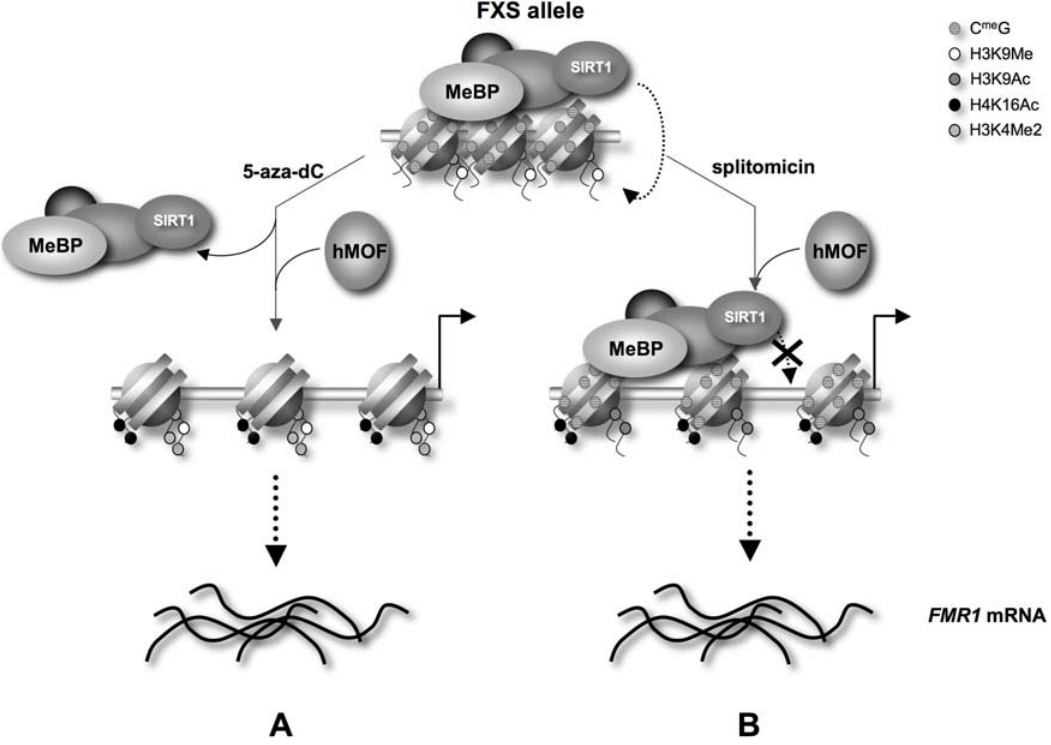
Figure 8. Model for the effect of 5-aza-dC and splitomicin on reactivation of FMR1 full mutation alleles. Binding of a DNA methyl- binding protein (MeBP) to the methylated 5 9 end allows SIRT1 to be recruited. This results in deacetylation of H4K16 and H3K9. The deacetylated H3K9 can now be methylated. A) Inhibition of DNA methylation prevents binding of the MeBP and thus the recruitment of SIRT1. This facilitates the acetylation of H4K16 by hMOF, which promotes chromatin opening and transcriptional activation. B) Inhibition of SIRT1, allows hMOF to acetylate H3K16 and thus to adopt a more open chromatin conformation without affecting DNA methylation.